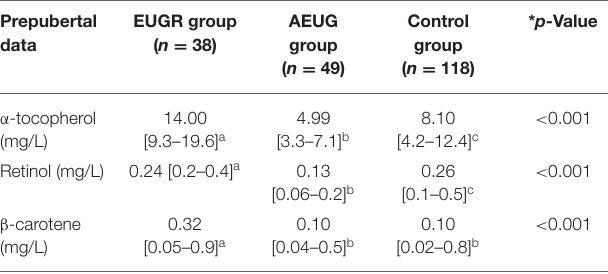
TABLE 3 | Plasma levels of non-enzymatic antioxidants in prepubertal children with a history of prematurity and extrauterine growth restriction (EUGR group), prematurity with adequate extrauterine growth (AEUG group), and healthy children (control group).